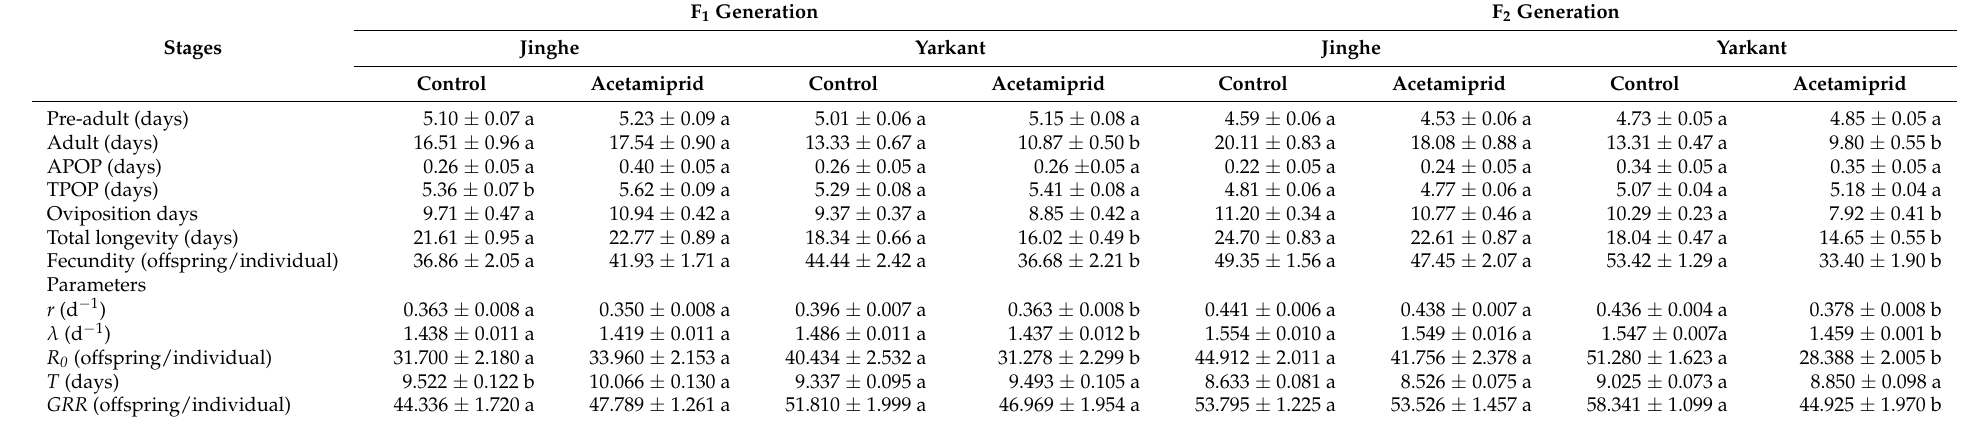
Table 2. Sublethal effects of acetamiprid on the duration of development and the population parameters of the F 1 and F 2 generations in Yarkant and